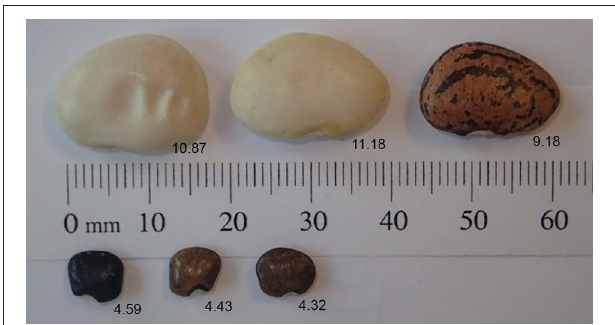
FIGURE 1 | Seeds of Phaseolus lunatus from domesticated varieties: on the top from left to right with the corresponding mean sizes in mm ( ± SE); Fordhook 242 (10.87 ± 0.47), Burpee’s Best (11.18 ± 0.92) and Jackson Wonder (9.18 ± 0.46). On the bottom line seeds from wild populations, from left to right; HGO (4.59 ± 0.2), Umar (4.43 ± 0.1), and Ink (4.32 ±